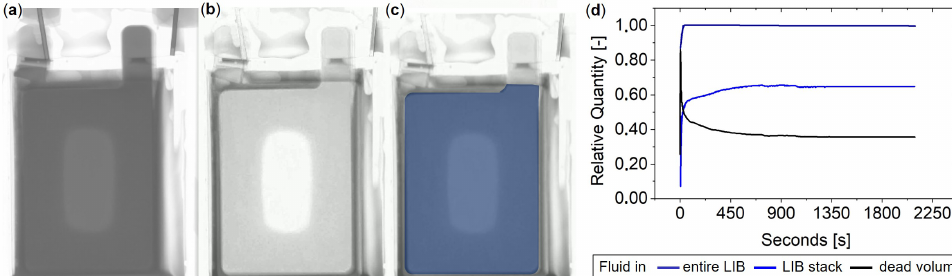
Figure 11. Image processing for evaluation of fluid distribution in an evacuated LIB around 10 s after dosing the fluid. ( a ): Preprocessed input image. ( b ): Calibrated differential image. ( c ): Masked LIB areas. ( d ): Distribution of fluid in the LIB stack and dead volume over